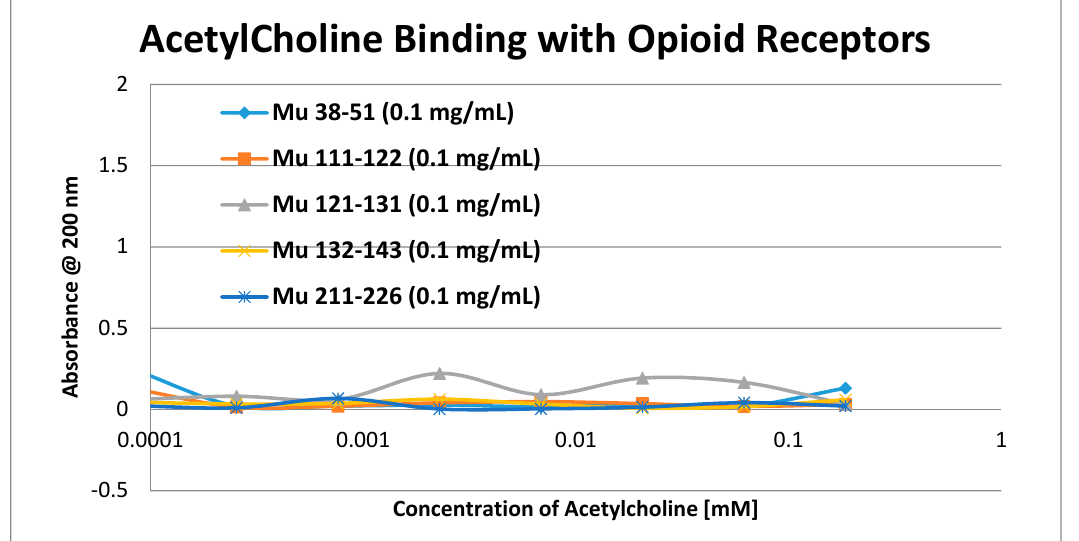
Figure 2. UV spectroscopic study of acetylcholine binding to mu opioid receptor (muOPR) peptides derived from the extracellular loop and adjacent transmembrane regions (see Figure 1).